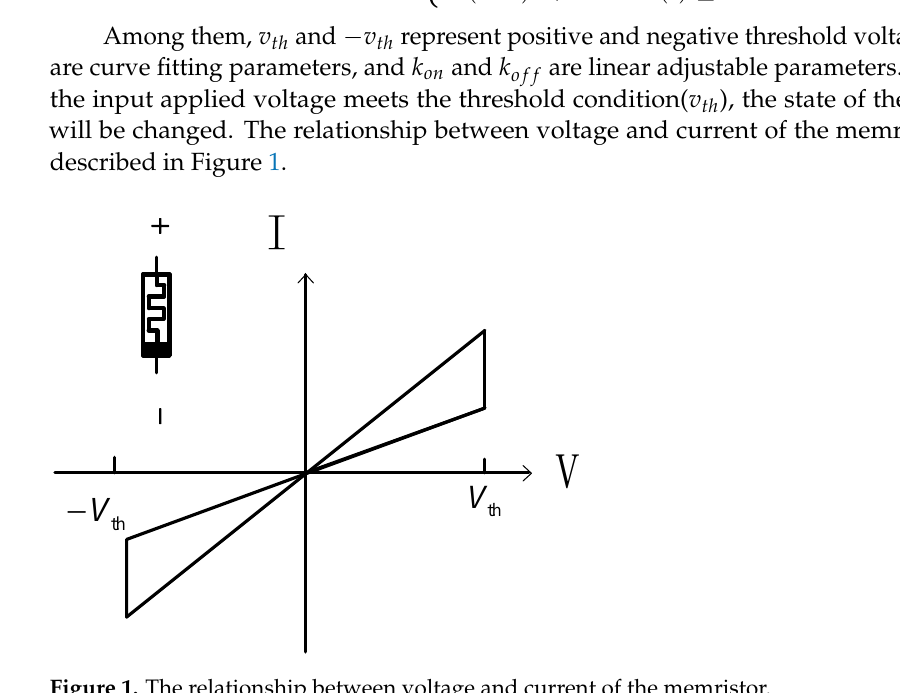
Figure 1. The relationship between voltage and current of the memristor.